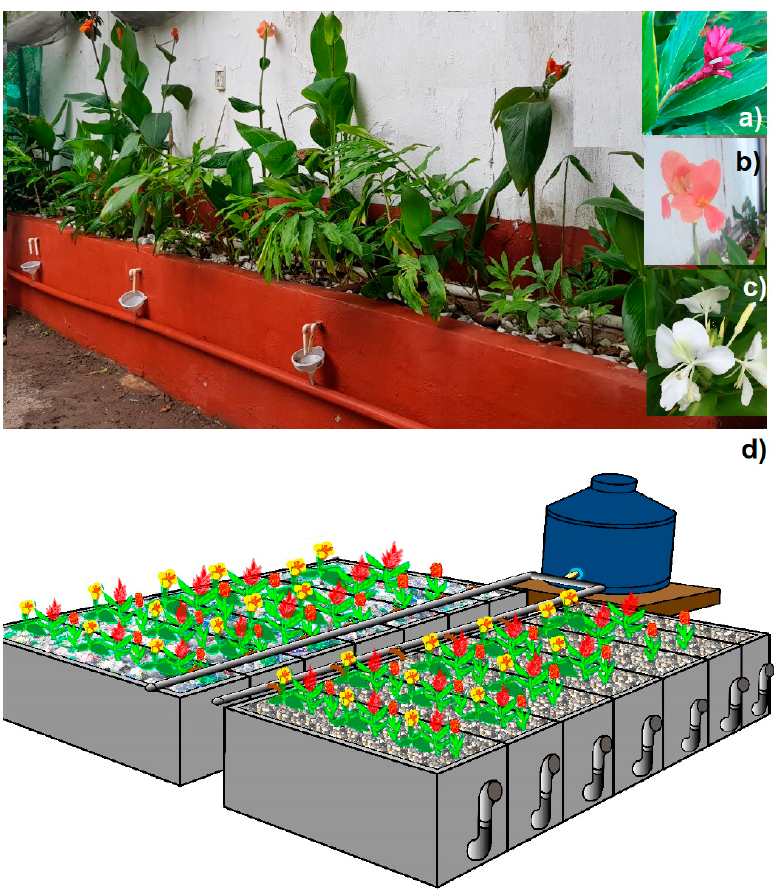
Figure 6. Constructed wetland systems. ( a ) Alpinia purpurata , ( b ) Canna hybrids , ( c ) Hedychium Figure6. Constructedwetlandsystems. ( a ) Alpiniapurpurata , ( b ) Cannahybrids , ( c ) Hedychiumcoronarium , coronarium , ( d ) Scheme of CWs in study. ( d ) Scheme of CWs in